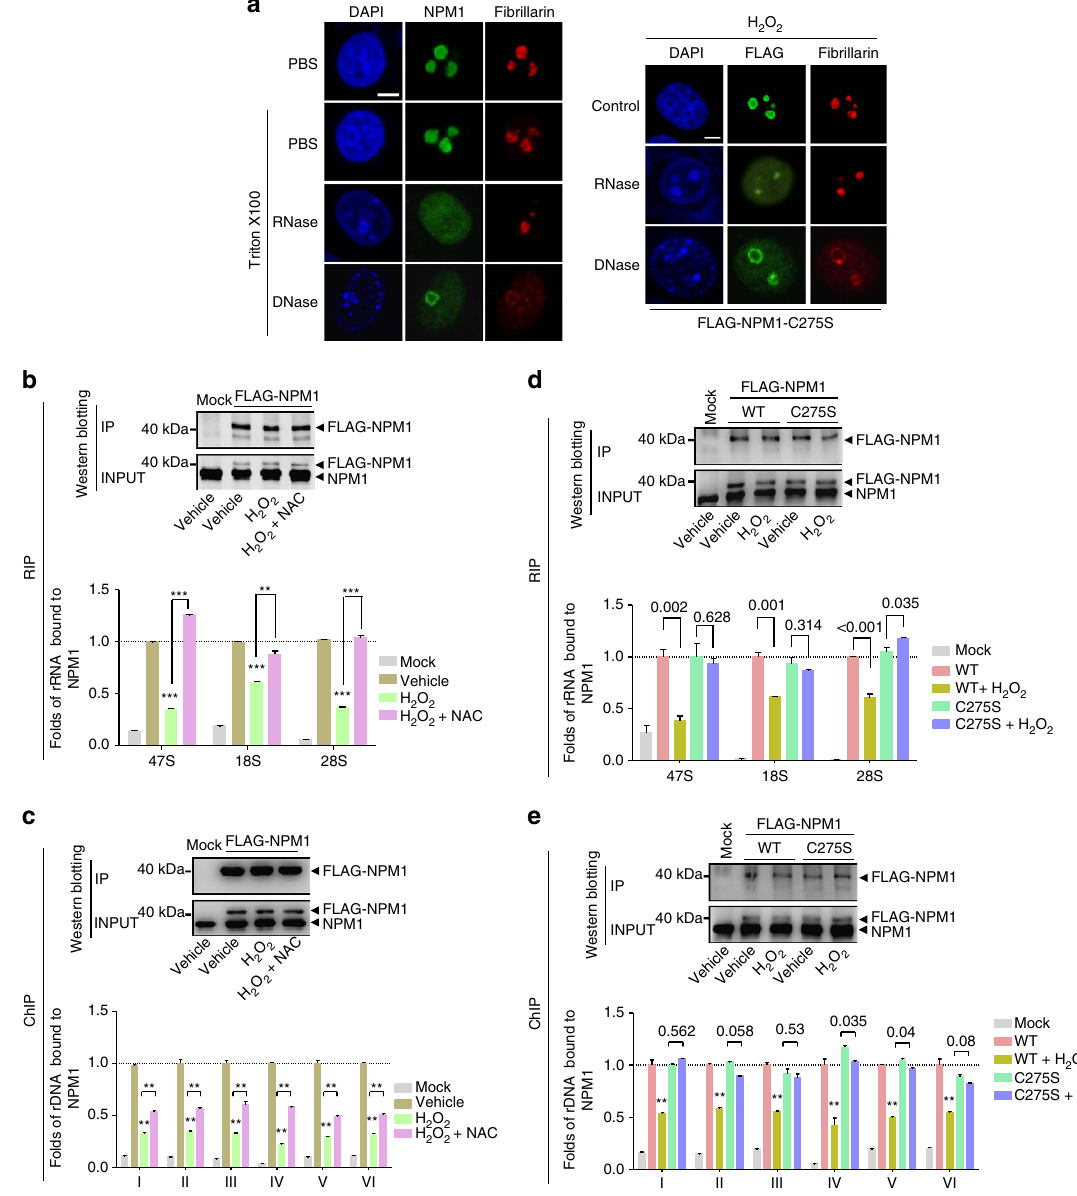
Figure 5 | NPM1 dissociates from rRNA/rDNA following S -glutathionylation. ( a ) Nucleoplasmic dispersion of endogenous NPM1 (left) or FLAG-NPM1 C275S (right) after RNase A (1mgml (cid:2) 1 ) and DNase I (0.5Uml (cid:2) 1 ) digestions in HeLa cells with or without H 2 O 2 (500 m M) treatment. ( b , c ) Equal quantities of FLAG-NPM1 immunoprecipitated by anti-FLAG M2 gel in RIP ( b ) and ChIP ( c ) assays in HEK293Tcells treated with H 2 O 2 (500 m M) ± NAC pretreatment, blotted by anti-NPM1 antibody (upper). The relative quantities of rRNA and rDNA bound with these FLAG-NPM1 were assessed (bottom). Unpaired t- test, ** P o 0.01 or *** P o 0.001 with respect to treated versus untreated or (cid:2) NAC versus þ NAC cells. ( d , e ) Similar experiments to b , c ; the relative quantities of rRNA ( d ) and rDNA ( e ) bound with FLAG-NPM1 WTor mutant C275S in HEK293Tcells exposed to H 2 O 2 (500 m M) were assessed. ** P o 0.01 or showed above the bars. In b – e , Mock referred to the transfection negative control, whereas Vehicle referred to the treatment negative control. Data were represented as mean ± s.e.m. Scale bars, 5 m m. The internal controls of RIP and ChIP assays are shown in Supplementary Fig.